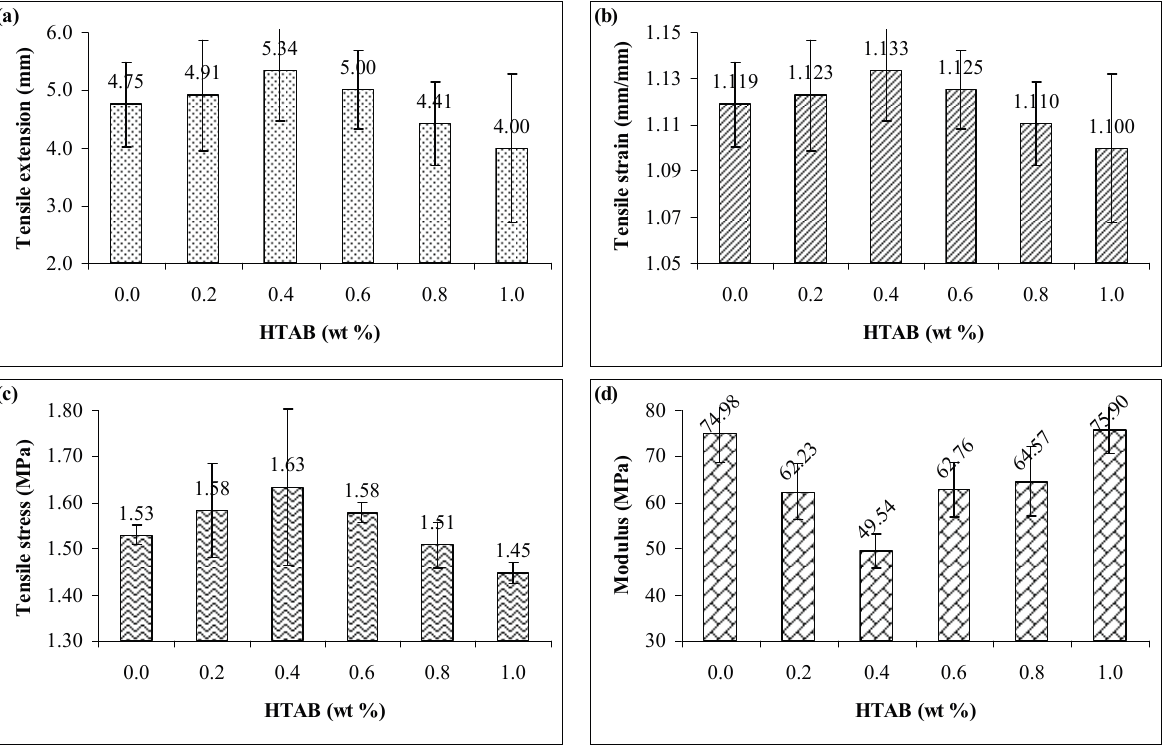
Figure 1. Influences of hexadecyltrimethylammonium bromide surfactant (HTAB) concentration on ( a ) tensile extension; ( b ) tensile strain; ( c ) tensile stress; and ( d ) modulus at break of low-density polyethylene (LDPE)/cellulose woven (CW)